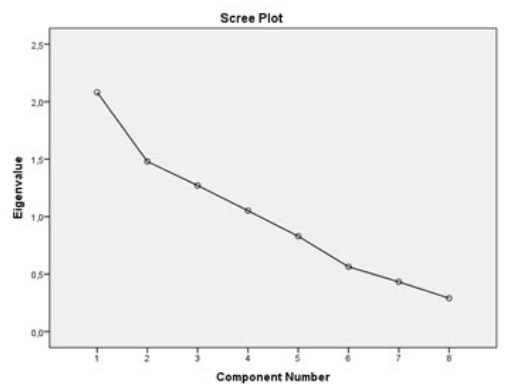
Figure 1. Scree Plot of cognitive ma-